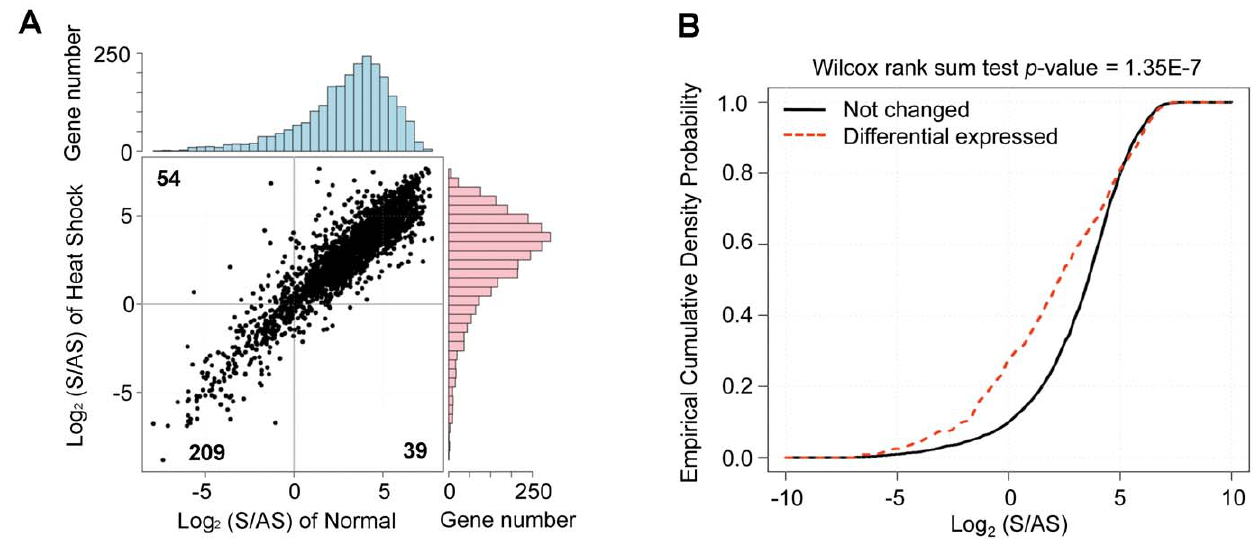
Figure 2. S.pombe genes with dominant antisense expression. (A) Dominantly expressed antisense transcripts under NM and HS conditions. Gene number for each quadrant is shown. The distribution of log 2 -transformed sense/antisense ratio of each condition is also shown. (B) Cumulative distribution of the sense/antisense ratio for gene groups, for which the level of sense transcript is either unchanged (black line) or altered (red dotted line) between NM and HS conditions.